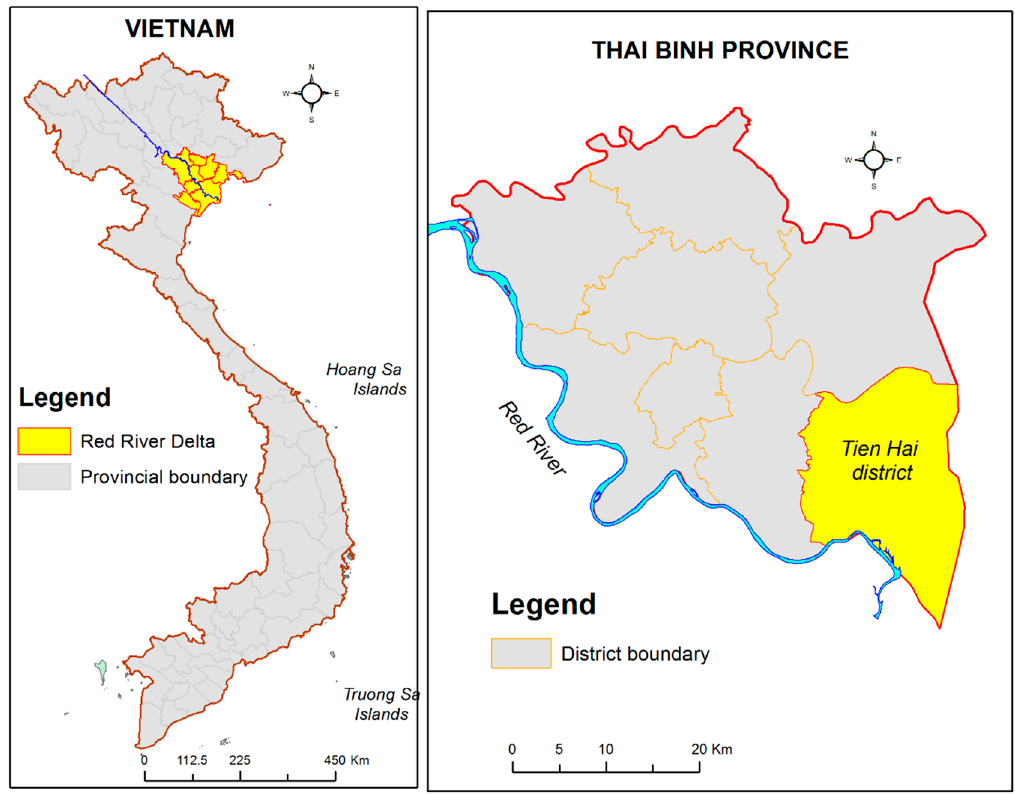
Figure 1. Study area. Tien Hai district is located in the coastal area of the Red River Delta, Vietnam, with 23 km of coastline. The district contributes an important role in agriculture production and biosphere reservation in the Red River